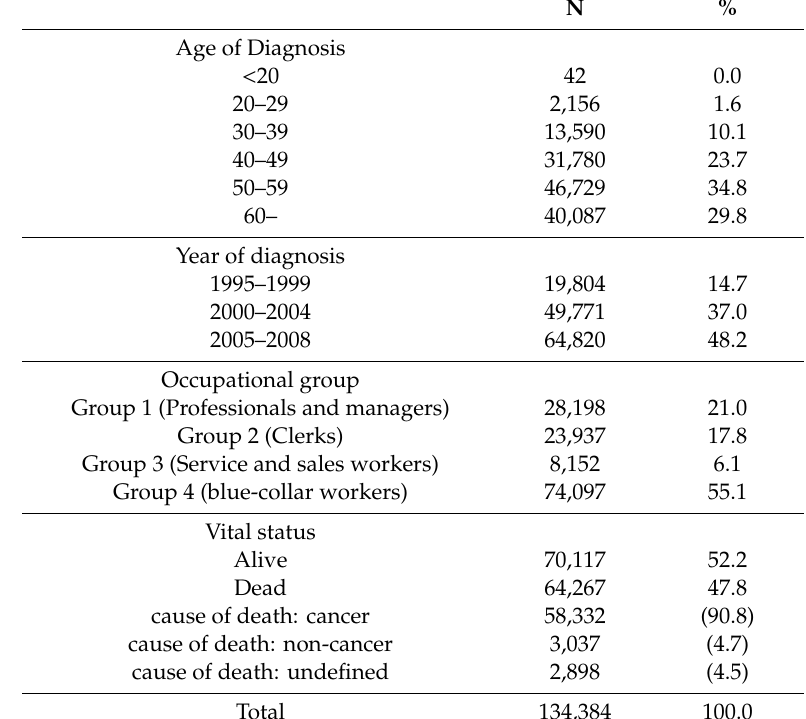
Table 1. Characteristics of 134,384 male cancer patients.